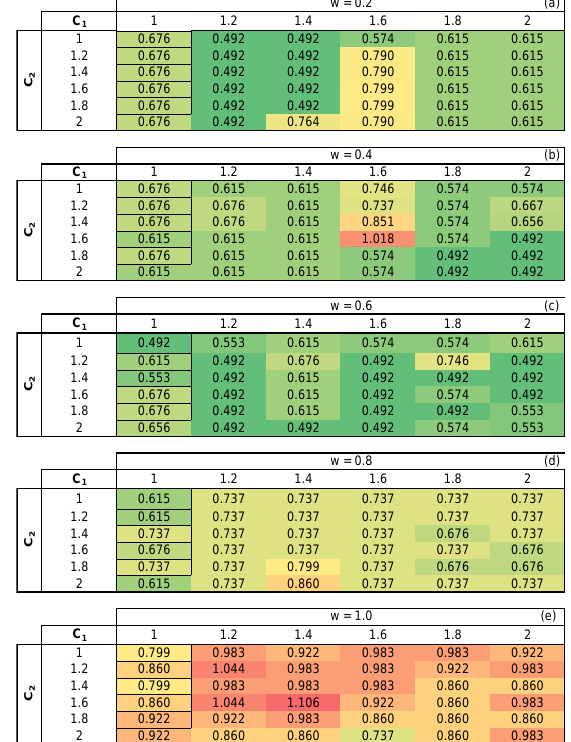
Table 4. Average convergence time in seconds for three particles.